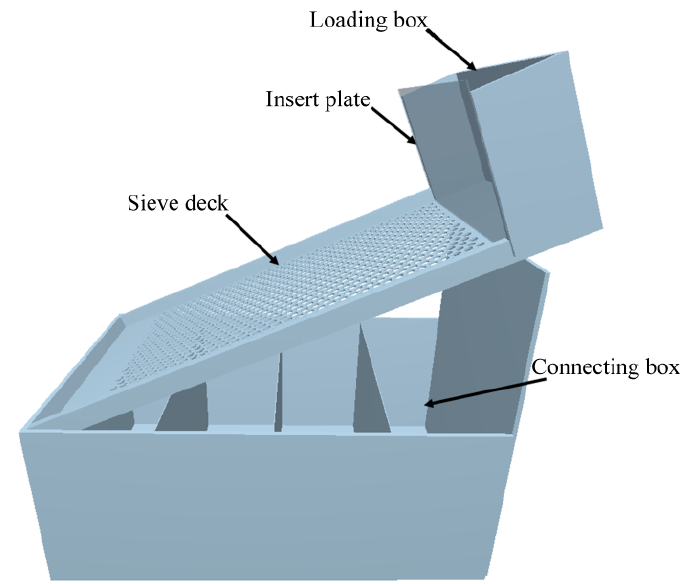
Figure 6. Schematic of the screening test.